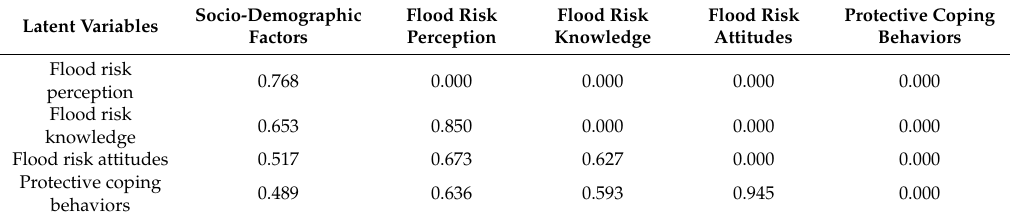
Table 6. Results of standardized total e ff ects in